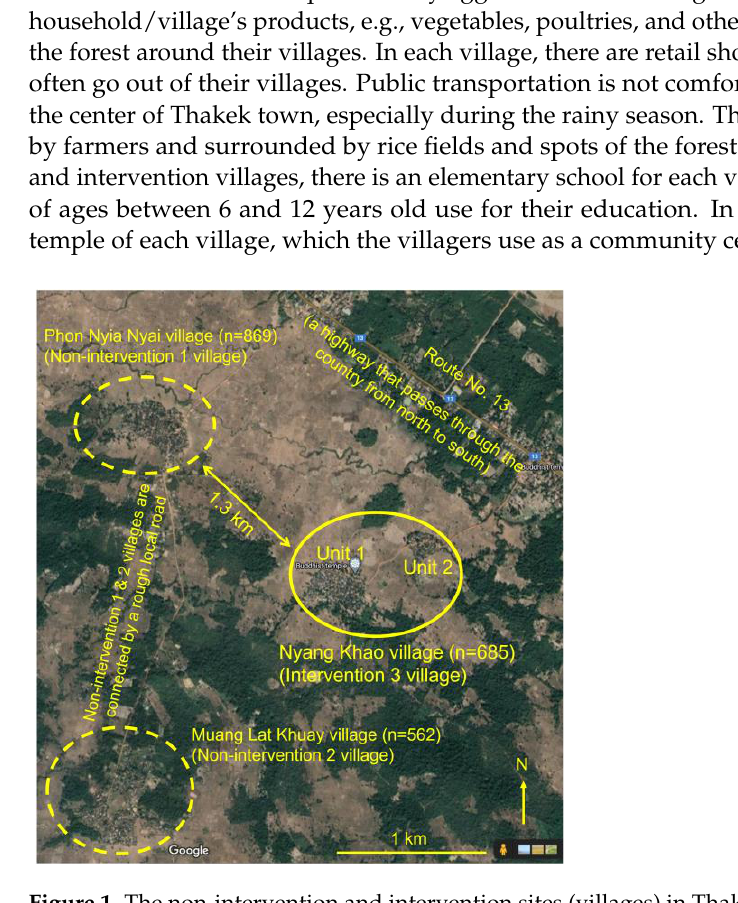
Figure 1. The non-intervention and intervention sites (villages) in Thakhek district, Khammouane Province. The map was modified from Lamaningao et al., 2020 [16]. Used aerial distances measure of Google